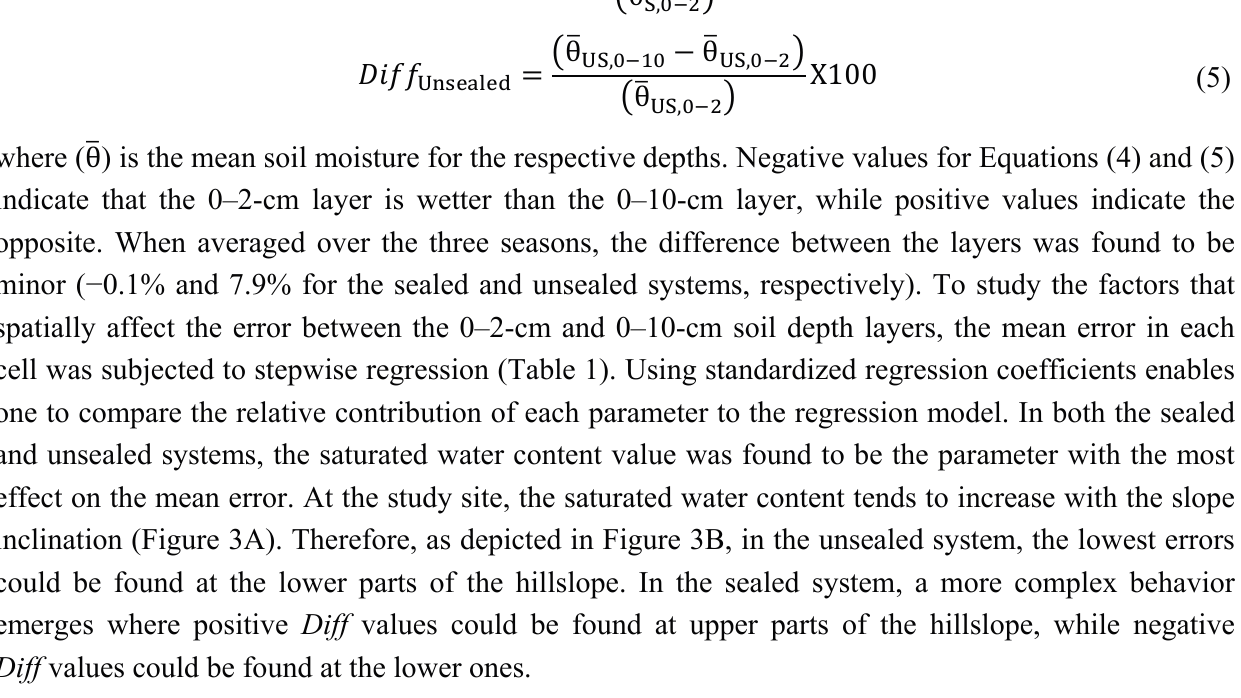
Table 1. Standardized beta coefficient values determined from the step-wise regression analysis of the mean difference in soil moisture between the 0–2 and 0–10-cm depth layers in each 30-m cell vs. five explanatory parameters. Dashed lines represent